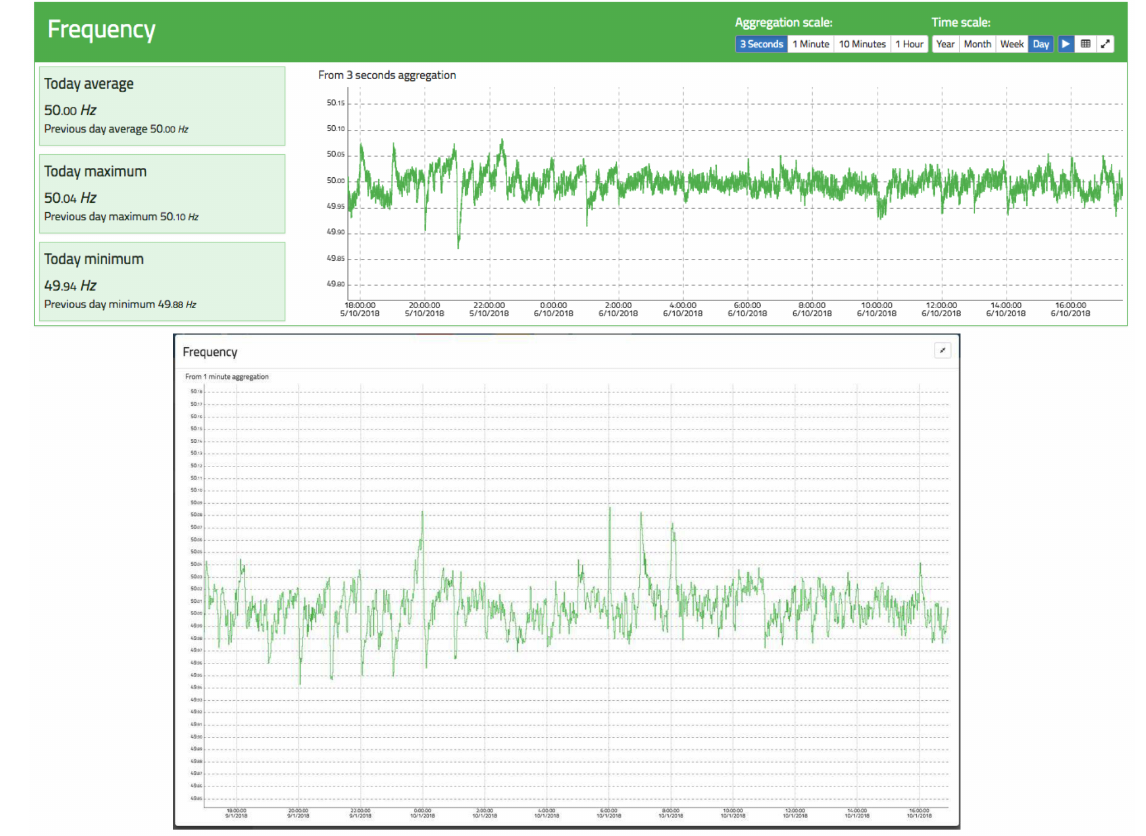
Figure 14. Frequency view of oZm. Top: general view. Bottom: maximized